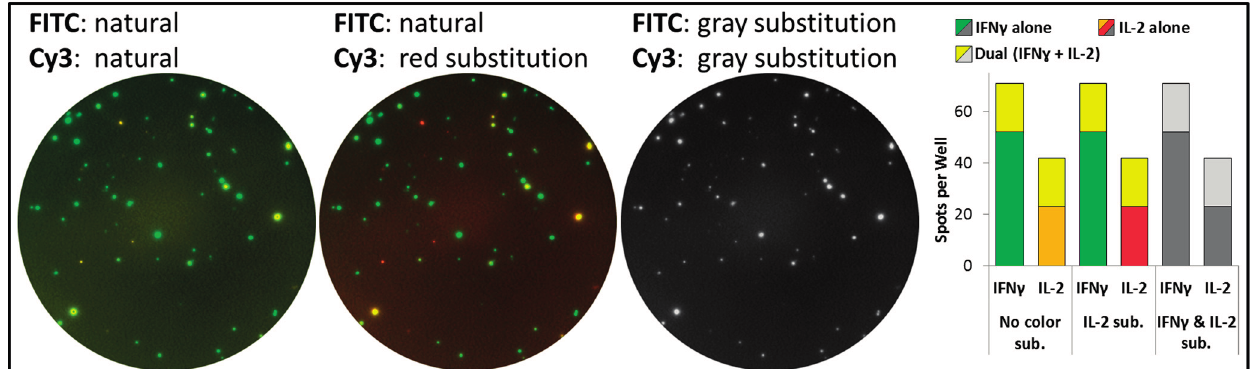
Figure 6. Influence of spot color on spot counts. Overlay images of one well of PBMC stimulated with CEF peptide pool stained for IFN ɣ (FITC) and IL-2 secretion (Cy3) are shown with natural appearing colors (left image), color substitution for Cy3 spots (center image) and substitution of both FITC and Cy3 with gray values (right image). Spot counts for each cytokine in each of the three color schemes are presented in the graph, indicating that independent of color adjustments to spots, overall evaluation results are the same for each cytokine and for dual